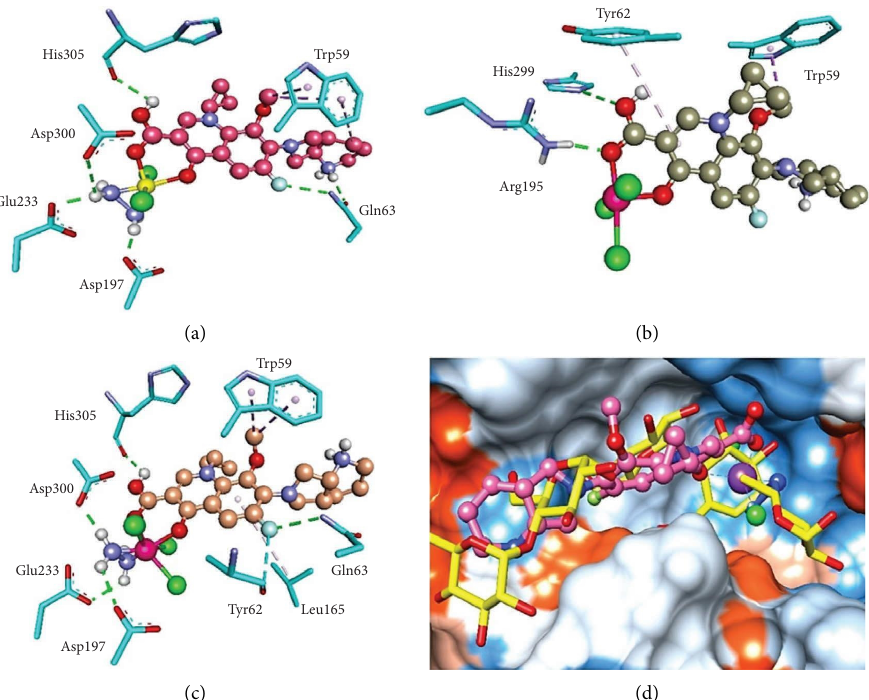
Figure 8: Te three-dimensional docking poses of compound 1 (a), compound 3 (b), and compound 4 (c) in a ball and stick model are represented in the active site of human α -amylase (PDB ID: 2QV4). Te residues are represented in the cyan stick model. Te yellow (a), pink (b), and green (c) balls represent Hg, Fe, and Cl, respectively. Green dotted lines represent conventional hydrogen bonds, whereas purple and light purple lines represent π -alkyl interactions. Te docking pose of compound 1 (in the pink ball and stick model) and cocrystallised ligand (acarbose in the yellow stick model) are shown in the active site cavity of the enzyme with the hydrophobic surface model